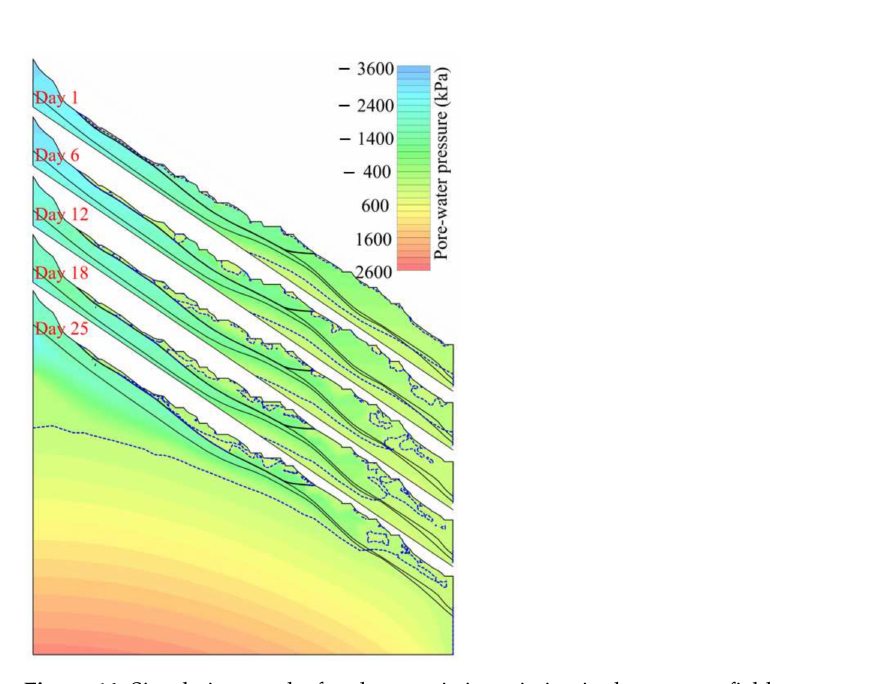
Figure 14. Simulation results for characteristic variation in the seepage field.